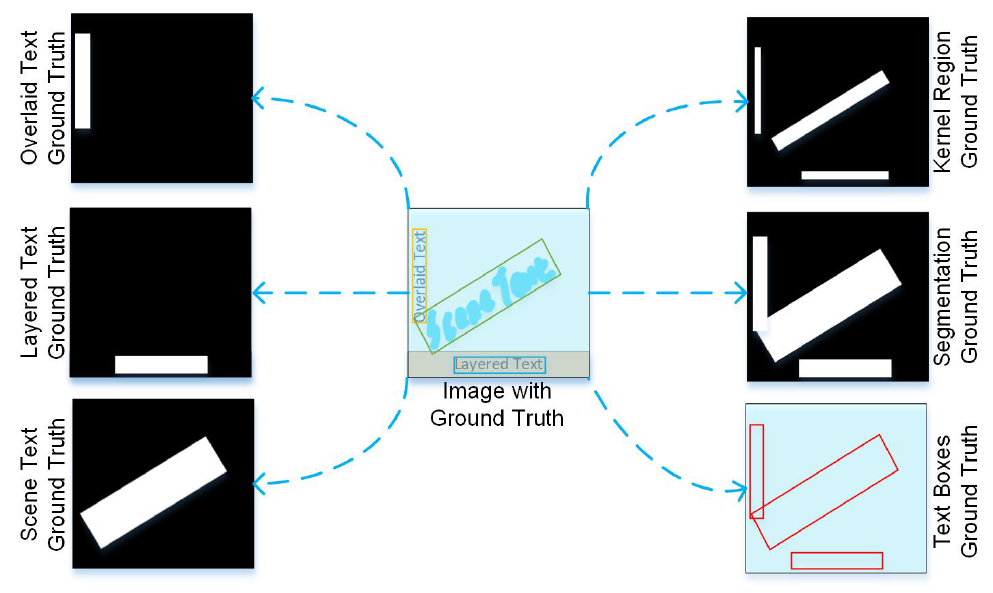
Figure 5. The generation process of localization labels ( right component ) and classification labels ( left component ). The localization labels consist of the text boxes’ ground truths generated by normalizing the ground-truth boxes and the segmentation and kernel regions’ ground truths generated by seg- menting and shrinking the ground-truth map. The classification label consists of three individual segmentation maps of different